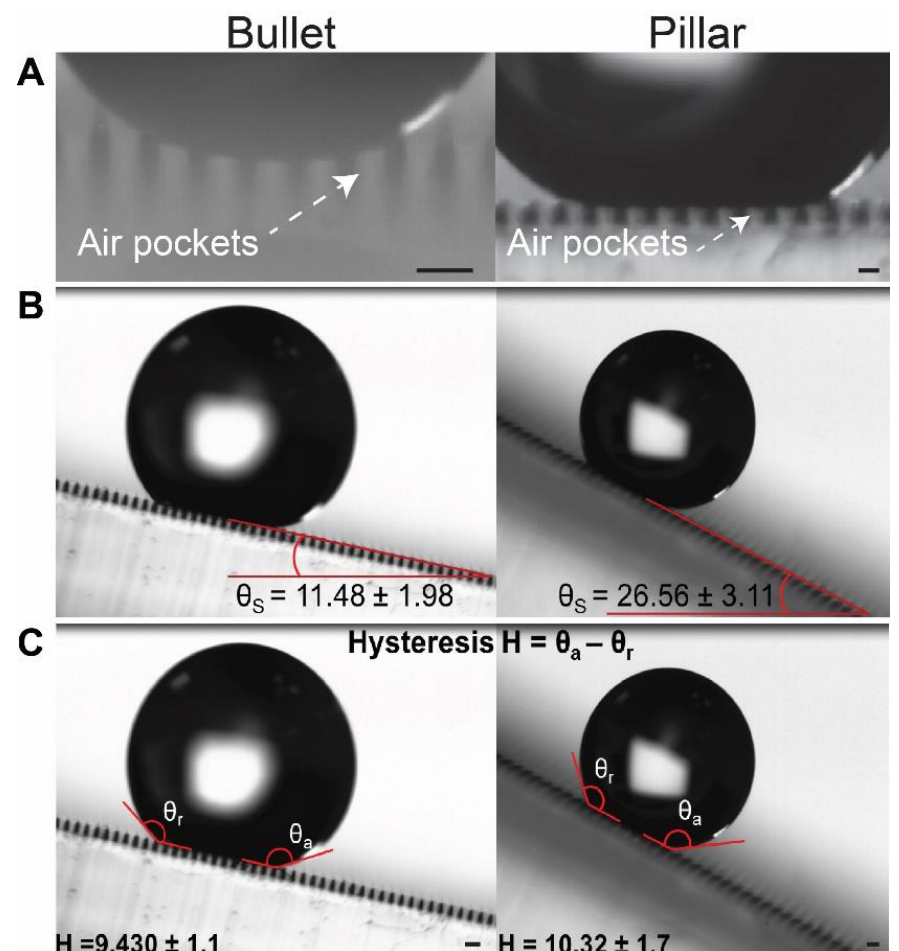
Figure 4. Characterization of the Cassie–Baxter regimen and surface adhesion. ( A ) The air pockets, trapped between the microstructures in the Bullet and the Pillar MSAs, establish that these structures were in Cassie–Baxter wetting condition. Further confirmation of superhydrophobicity was shown through ( B ) the roll-off angle and ( C ) hysteresis analysis. The low roll-off angle and hysteresis define that these two structures formed a superhydrophobic surface. Scale bar: ( A , C ) 100 µm.